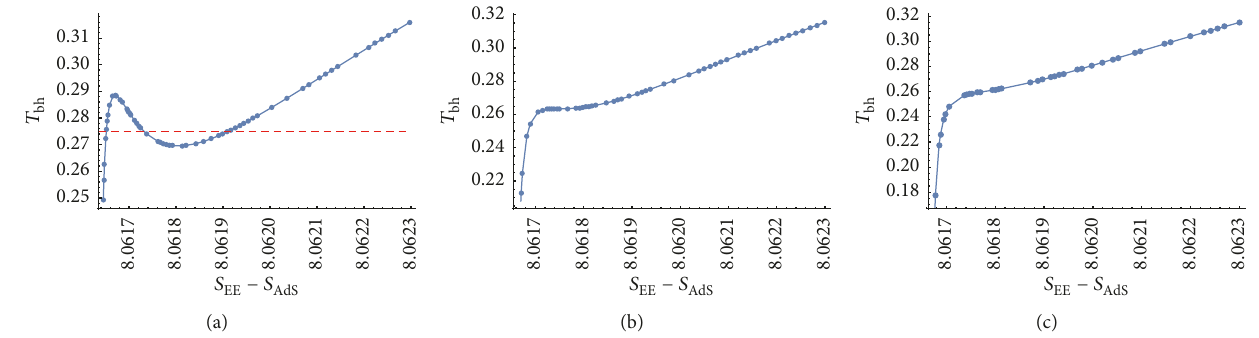
Figure 9: The figure shows 𝑇 versus 𝛿𝑆 for 𝛾 = −1 , 𝜑 0 = 0.10 . Here 𝜆 = 2.4 , 𝑄 = 0.6𝑄 𝑐 , 𝑄 𝑐 , 1.2𝑄 𝑐 from (a) to (c).